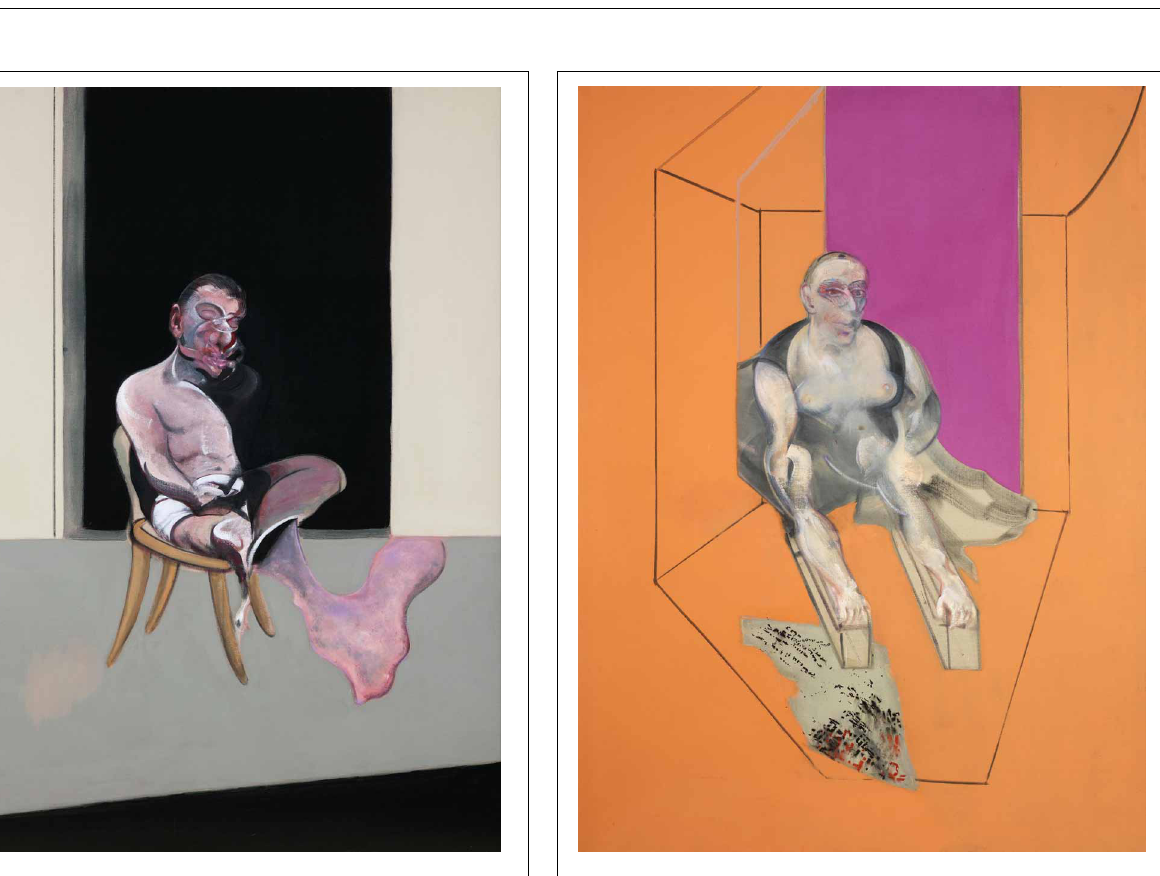
unusual in shape but other than that there is nothing about it that is shocking, even in spite of its somewhat unusual shape. Equally, the furnishings of Figure 14 are all fairly normal, while the face of the sitter is severely deformed. Such examples may be multiplied and attest to one difference between his rendering of bodies and faces on the one hand and objects on the other: he deformed and mutilated the former but left the latter largely